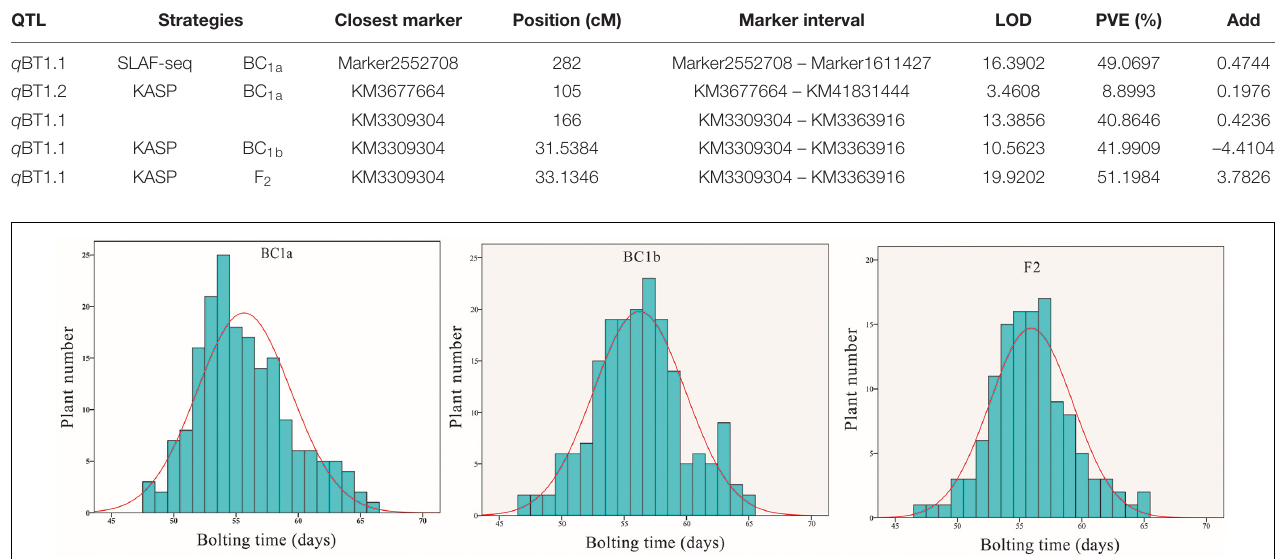
TABLE 1 | QTL analysis of spinach bolting.